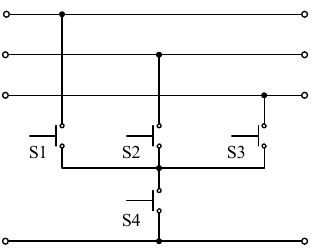
Figure 10. The schematic diagram of the short-circuit fault generator module.